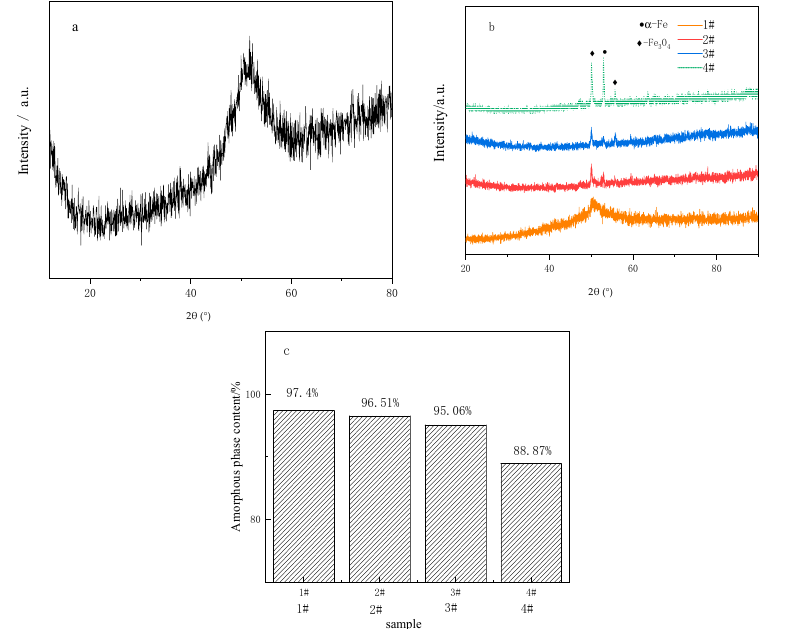
Figure 3. Crystallization of FAA before and after laser re-melting: ( a ) XRD pattern of raw powder; ( b ) XRD pattern of coating re-melted by lasers with different ° of power; ( c ) amorphous content of different coatings.